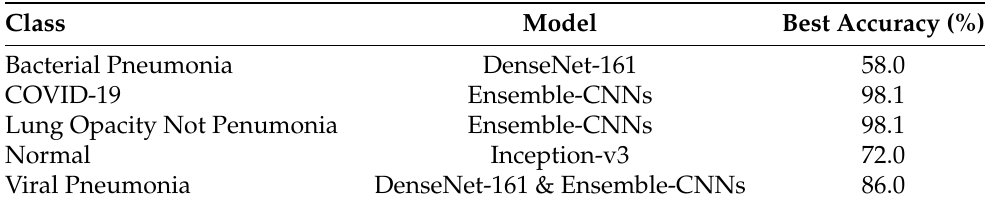
Table 12. The best classification method for each class of the testing split of the five-class scenario.